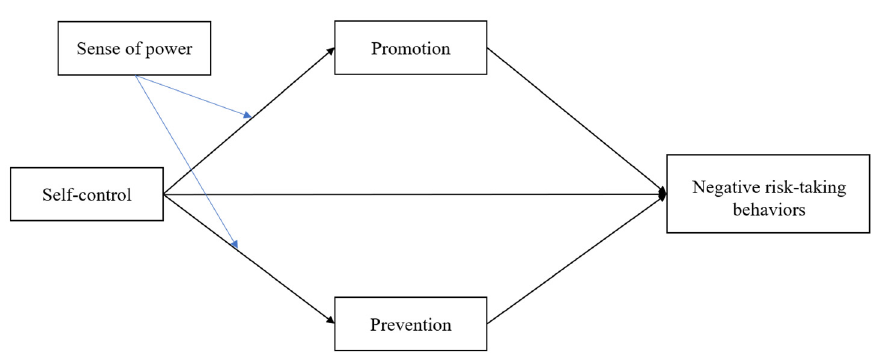
Figure 1. The conceptual model.